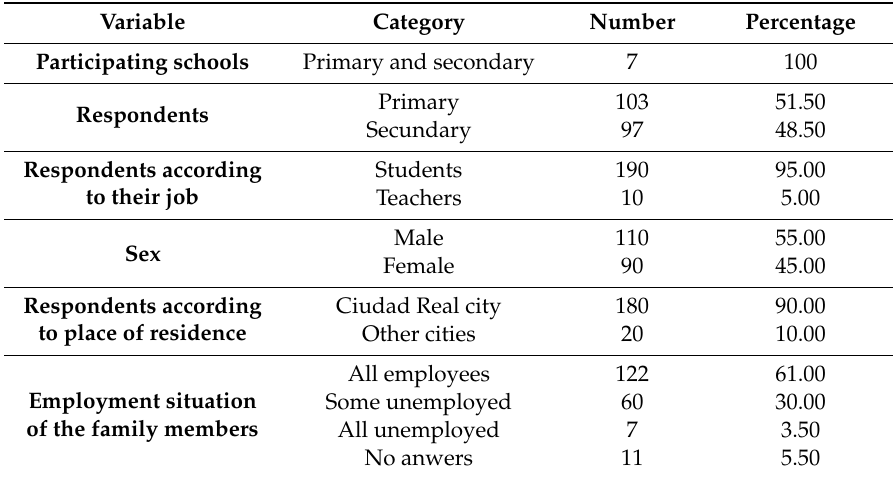
Table A2. Descriptive Results of